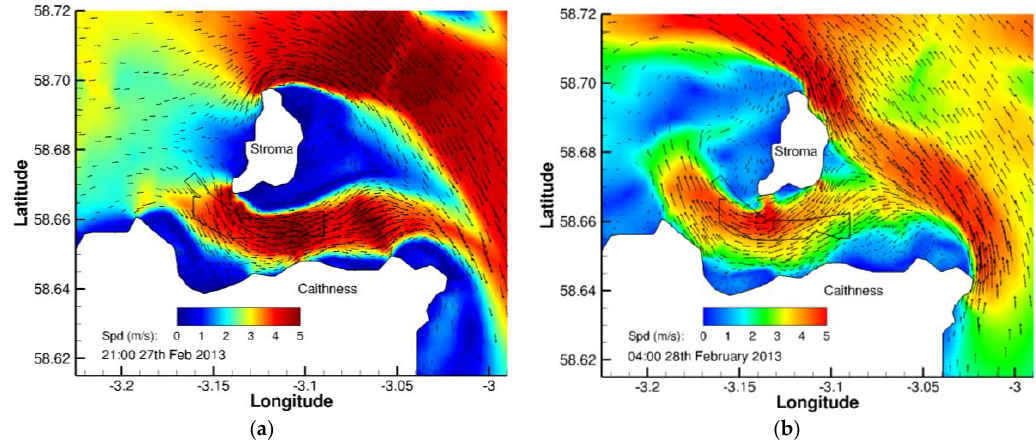
Figure 6. Model-predicted near-bed currents on a spring tide flood ( a ) and ebb ( b ) in the Inner Sound on 27–28 February 2013 in the simulation without turbines. Current vectors (m·s −1 ) are overlain on the coloured current speed (m·s −1 ). For clarity, only 6% of vectors are shown.